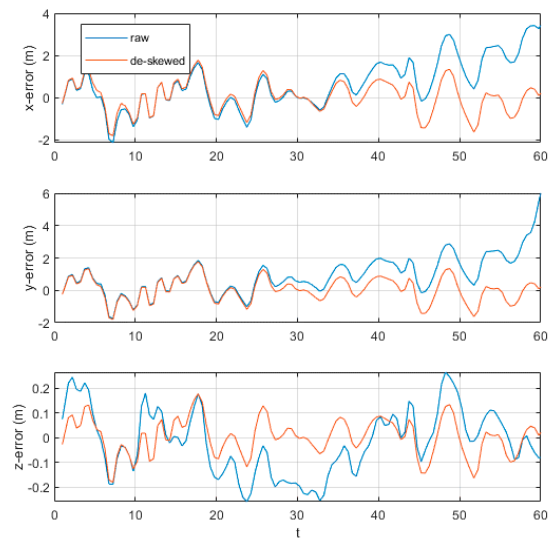
Figure 19. Errors in the outdoor test. Table 2. Pose accuracy in the outdoor experiment.